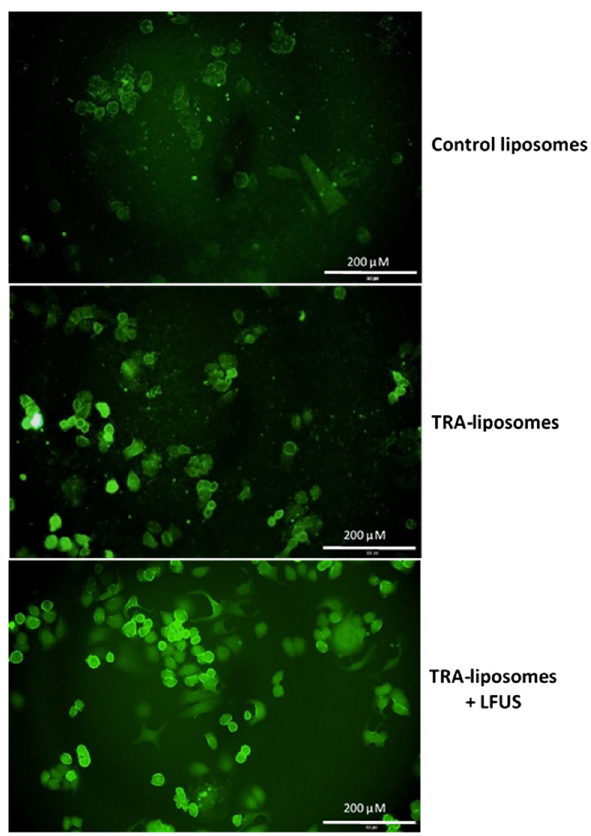
Figure 5. Fluorescence microscopy images of SKBR3 cells following 4 h incubation with control and TRA- liposomes encapsulating calcein in addition to TRA-liposomes exposed to LFUS (35-kHz) for 5 min.